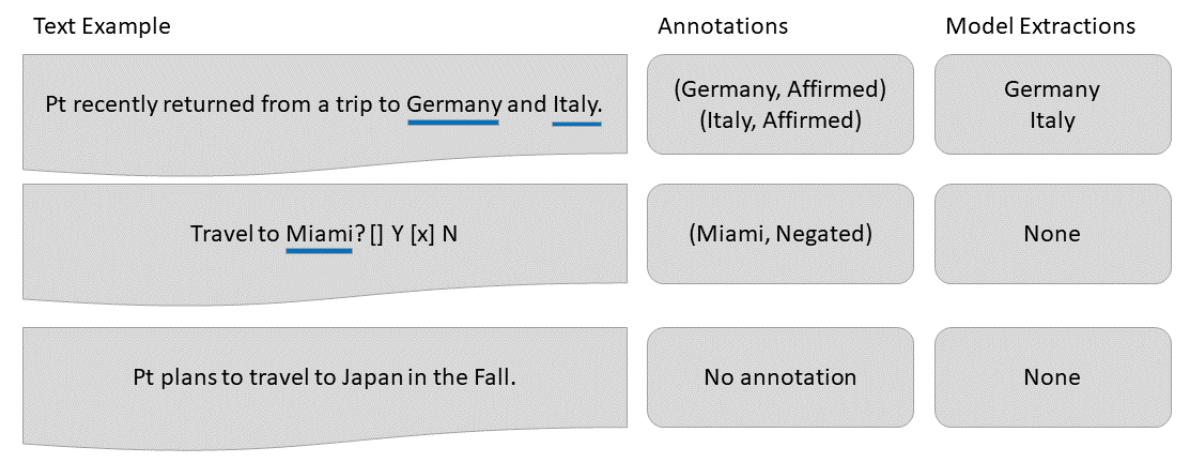
Figure 1. Illustration of this study's contributions. Included here are synthetic text examples, annotation output format, and model extraction of positive location mentions now deployed for public health